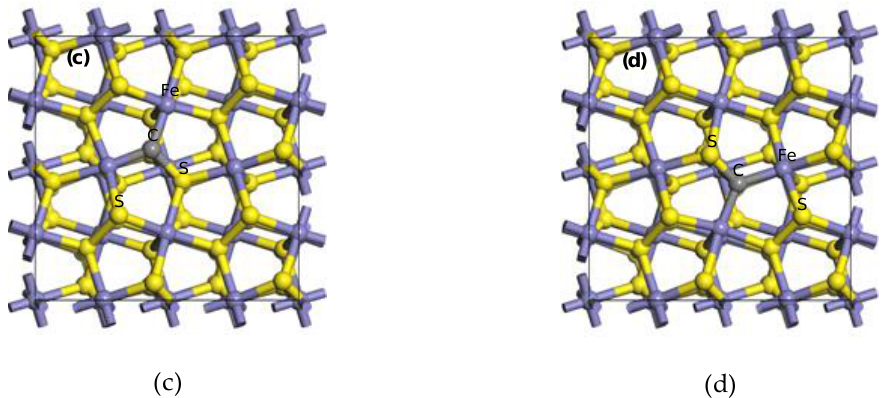
Figure 1. The doping model of one carbon atom-substituted pyrite surface: ( a ) I; ( b ) F; ( c ) HS; ( d ) LS.